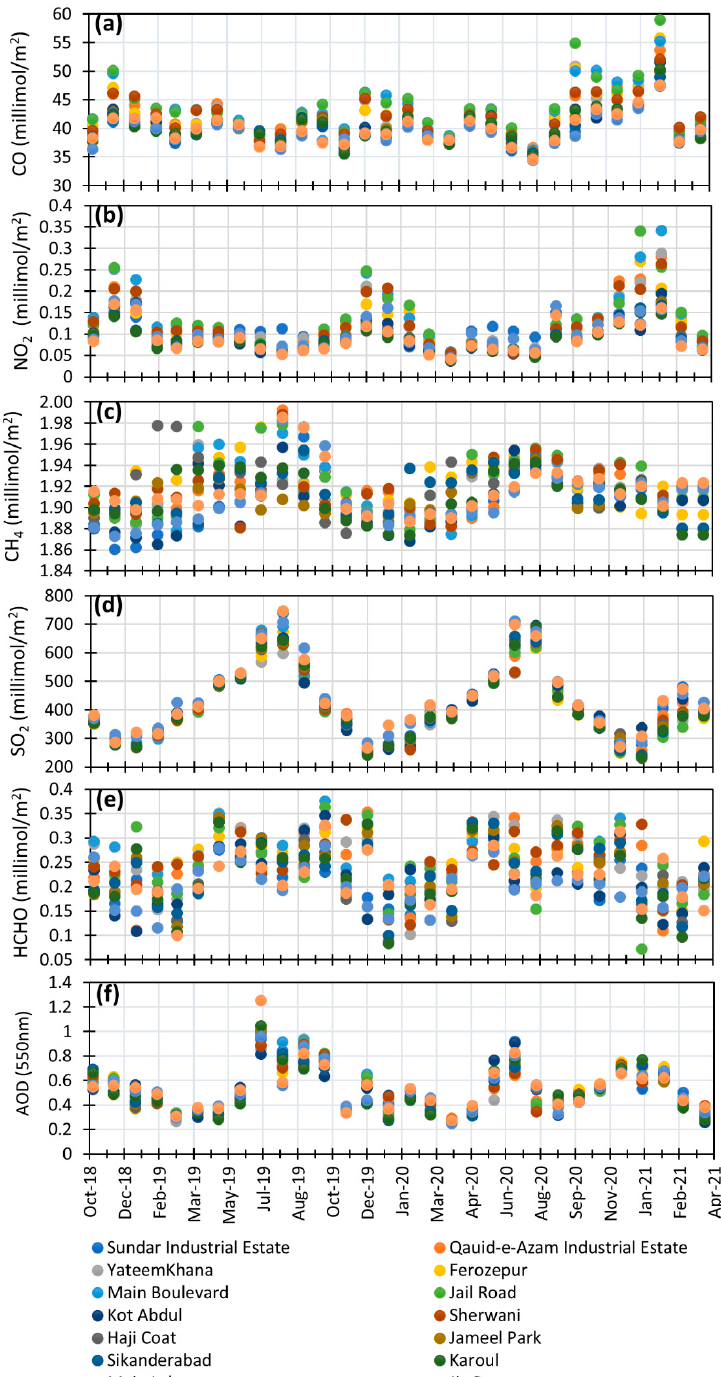
Figure 2. Temporal patterns of pollutant concentrations across spatially dispersed sites belonging to three sectors (roads, industrial estates, and brick kilns): ( a ) carbon monoxide (CO), ( b ) nitrogen dioxide (NO 2 ), ( c ) methane (CH 4 ), ( d ) sulphur dioxide (SO 2 ), ( e ) formaldehyde (HCHO), ( f ) aerosol optical depth